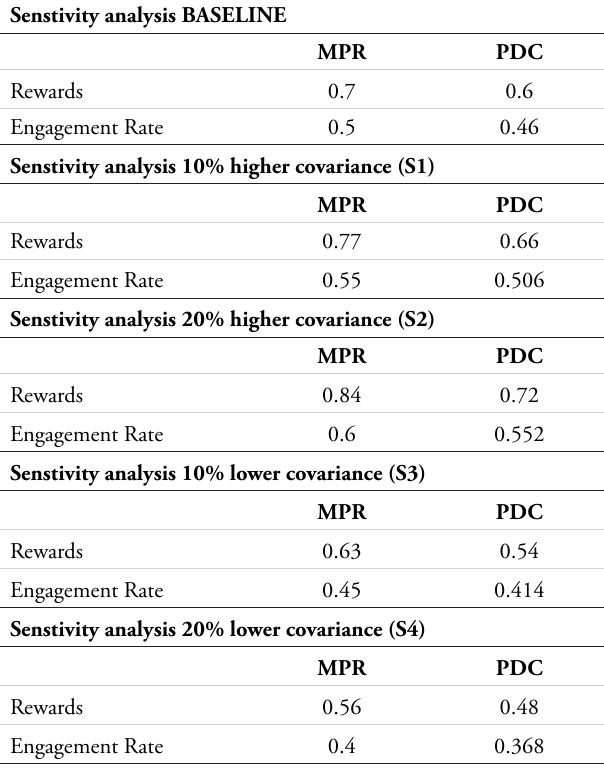
Table 4. Scenarios Representing Sensitivity Analysis on Covariance of Rewards and Engagement Rate With Adherence Rate Measures (MPR and